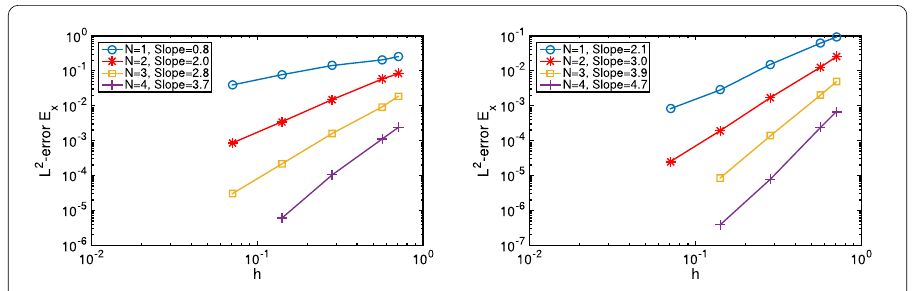
Figure 2 (cid:9) E M x – ˆ E M x (cid:9) versus h for the explicit leap-frog method. Left: central flux; Right: upwind flux L 2( (cid:4) )